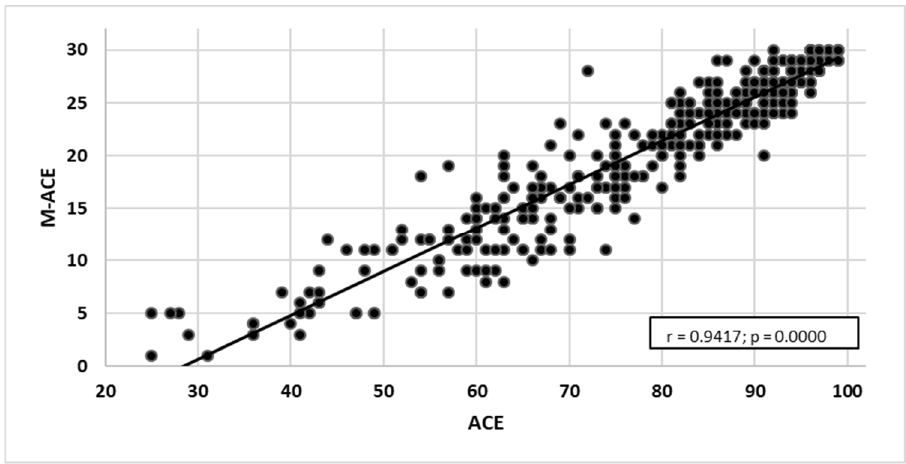
Figure 8. MMSE test results correlated with M-ACE test results ( n = 386).